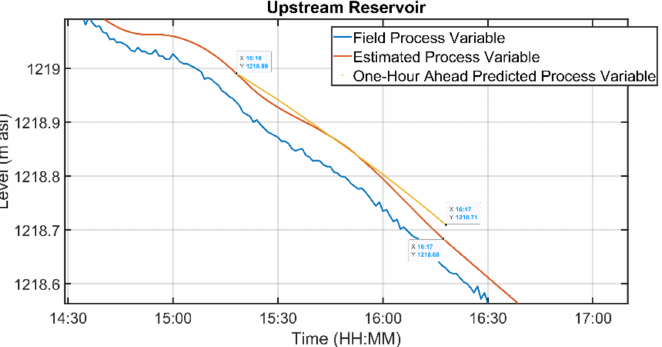
Figure 16. Modelization results: upstream reservoir level (blue line), predicted level with available data on input–output flow rates (red line), and one-hour-ahead prediction (orange